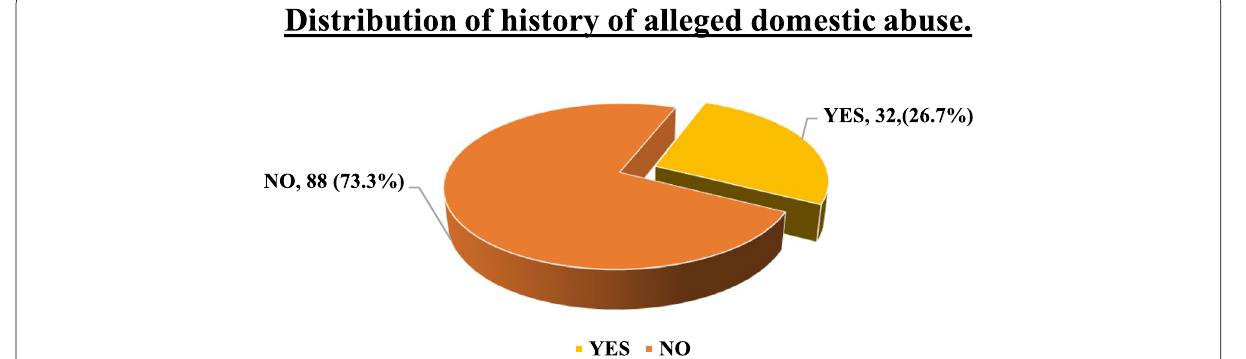
Fig. 5 Distribution of history of alleged domestic